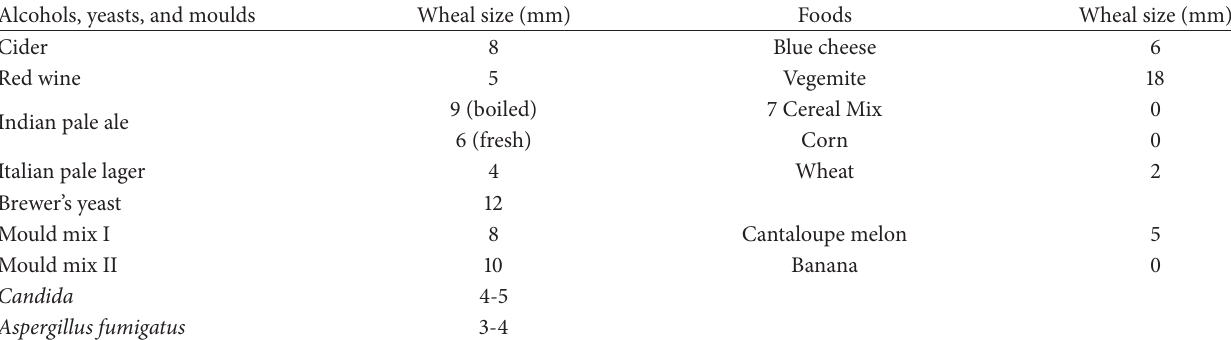
Table 1: Skin prick and raw food testing